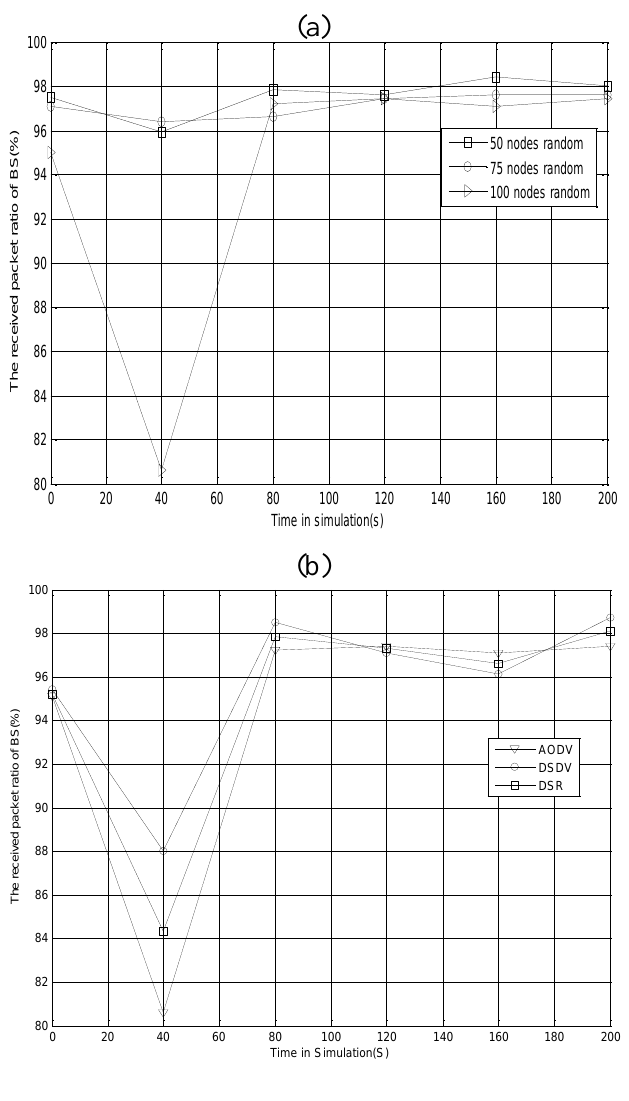
Figure 11. (a). Different node density on the impact for the RPR of BS; (b). Different routers on the impact for the RPR of